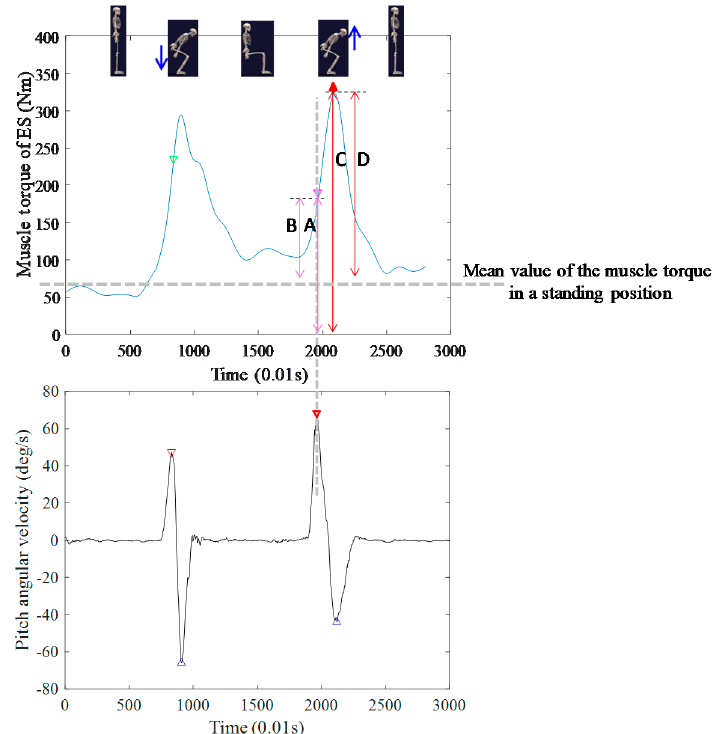
Figure 4. Indices for muscle torque evaluation.